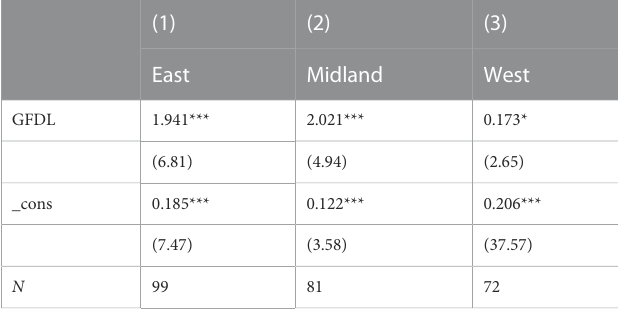
TABLE 7 Regression results based on Hypothesis 1 sub-region without the inclusion of control variables.